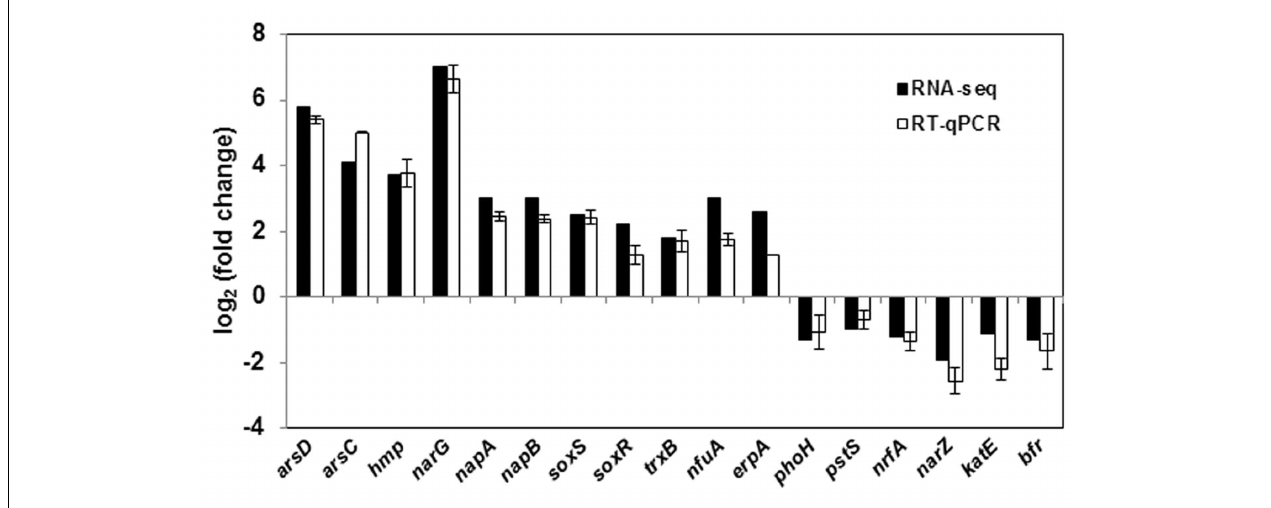
FIGURE 1 | RT-qPCR validation of 17 genes with significant differential expression in As(V) stress. RT-qPCR data are mean ± SD from three biological replicates.